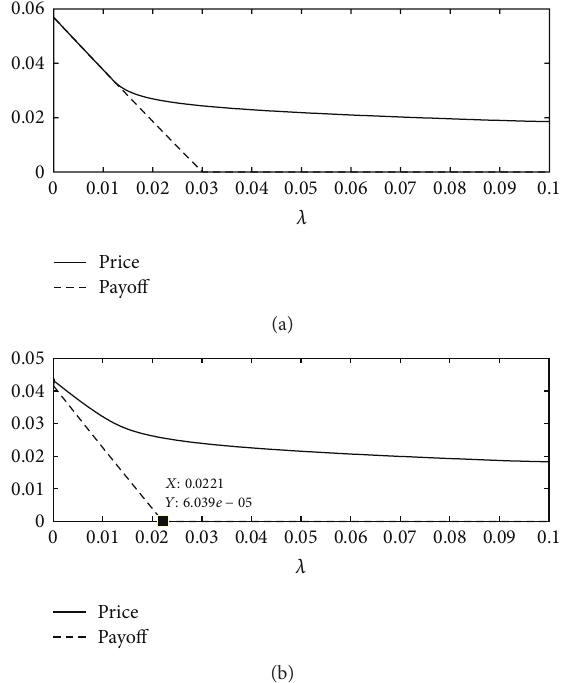
Figure 9: The price of the prepayment option 𝑃 Λ ∗ (𝜆) (solid line) and the payoff 𝜒(𝜆) (dashed line) as function of the intensity 𝜆 . (a) regime 𝑋 = 𝑒 1 ; (b) regime 𝑋 = 𝑒 2 . Two regions appear: the continuation region 𝜆 > Λ ∗ 1 and the exercise region 𝜆 ≤ Λ ∗ 1 . For the second regime there is no exercise